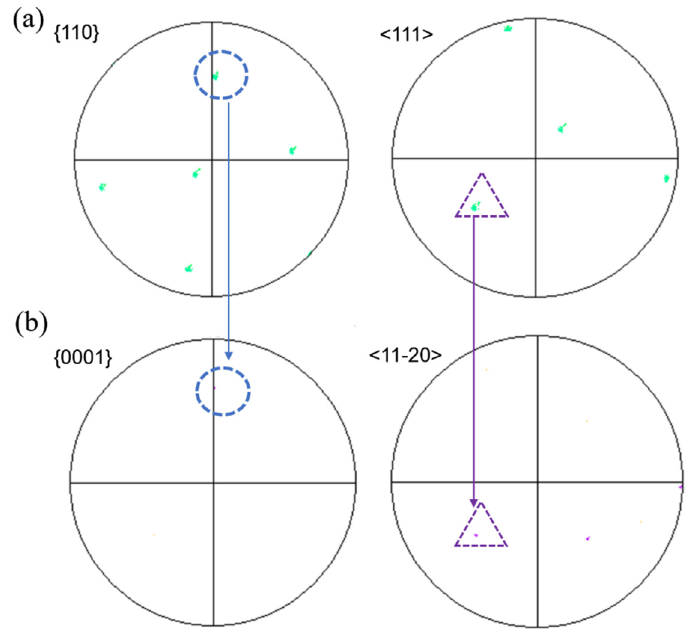
Figure 12. ( a ) {110} and <111> pole figures of the B2 phase, ( b ) {0001} and <11 2(cid:3364) 0> pole figures of the #22 α 2 particle.